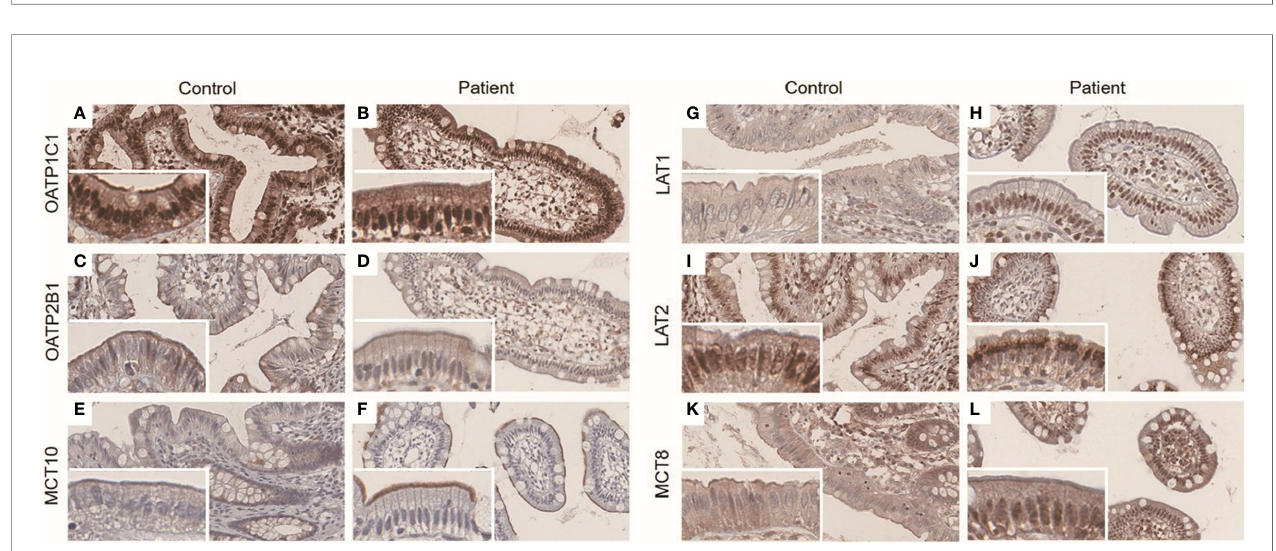
FIGURE 3 | (A – K) Immunohistochemistry result of ileal LT4 transporters in distal ileum. The panels were taken at × 20 magni fi cation, and inset represents × 40 magni fi cation. OATP1C1 was expressed in both nucleus and brush border in control (A) and the patient (B) . OATP2B1 and MCT10 were mainly expressed in brush border in control (C, E) and the patient (D, F) , respectively. LAT1 was mainly expressed in brush border in control (G) , whereas there was perinuclear staining in the patient (H) . LAT2 was detected at both perinuclear area and brush border in control (I) , but was stained at only perinuclear area in the patient (J) . The expression of MCT8 was not able to check in the patient due to lack of remnant ileal tissue. It was mainly expressed in brush border in control (K)